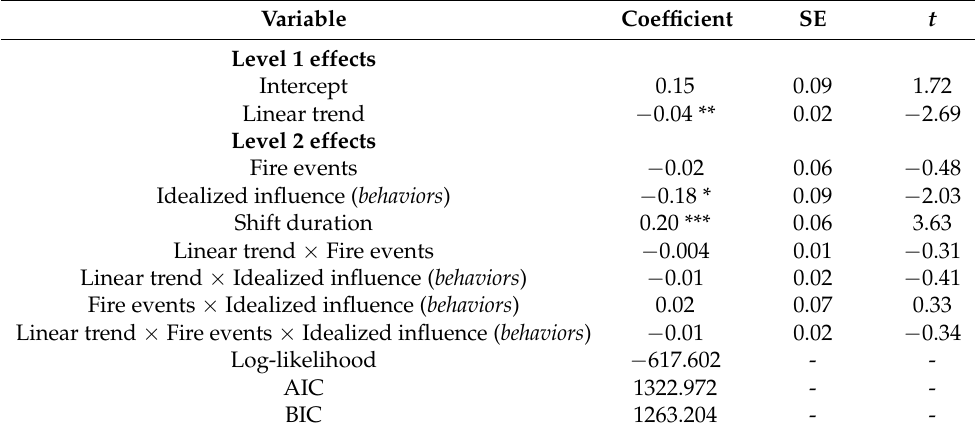
Table A6. Fire Events and Idealized Influence (Behaviors) Predicting Change in Emotional Exhaustion.